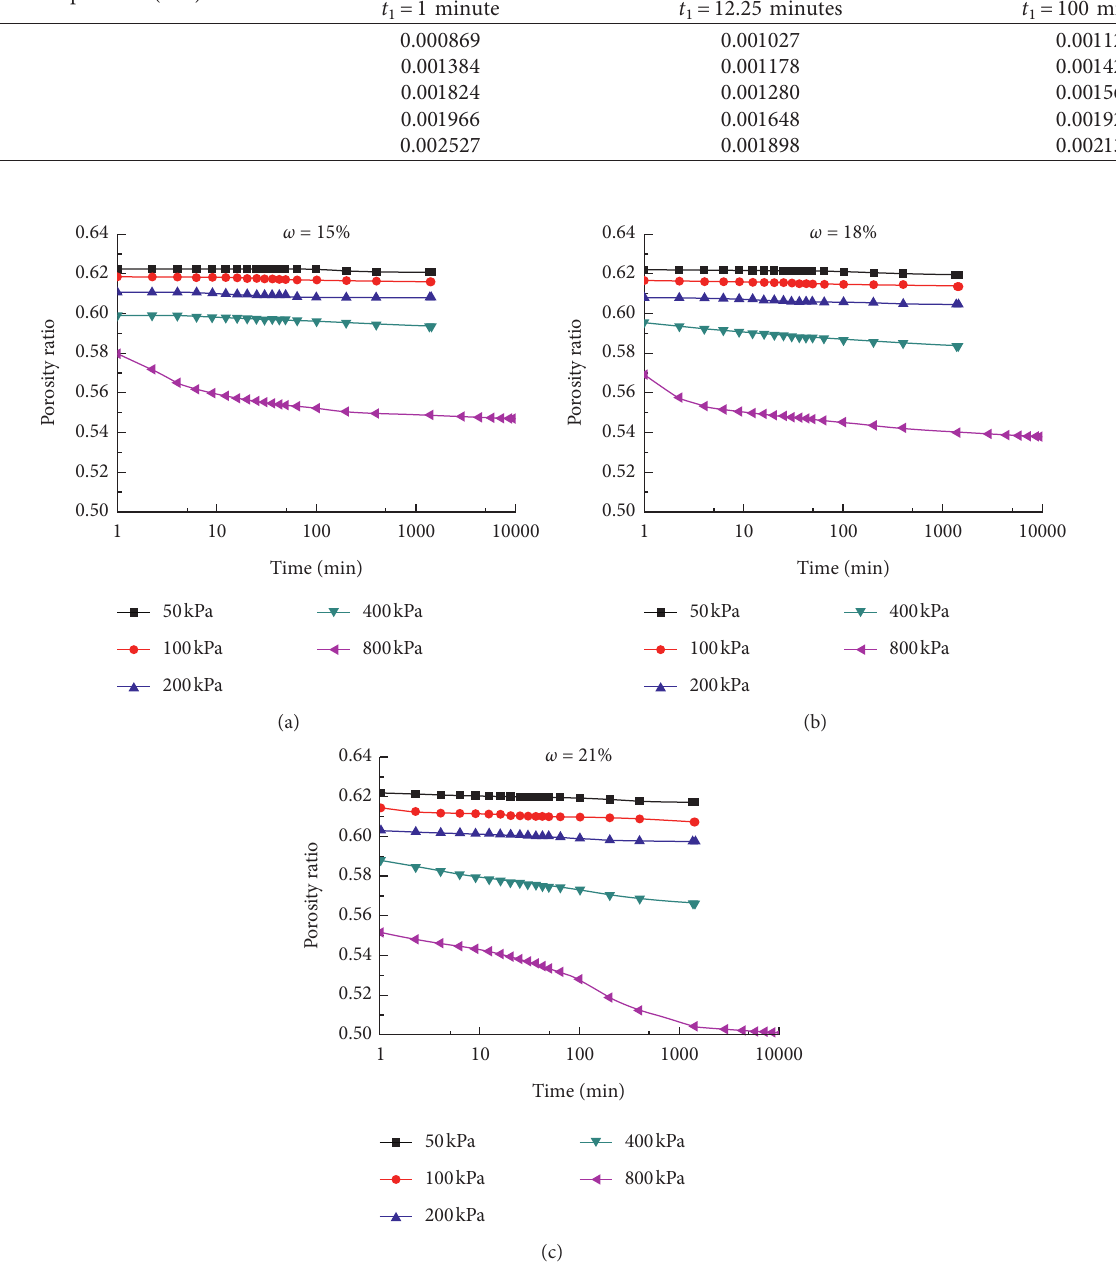
Figure 5: Consolidation test curve of expansive soil under different moisture